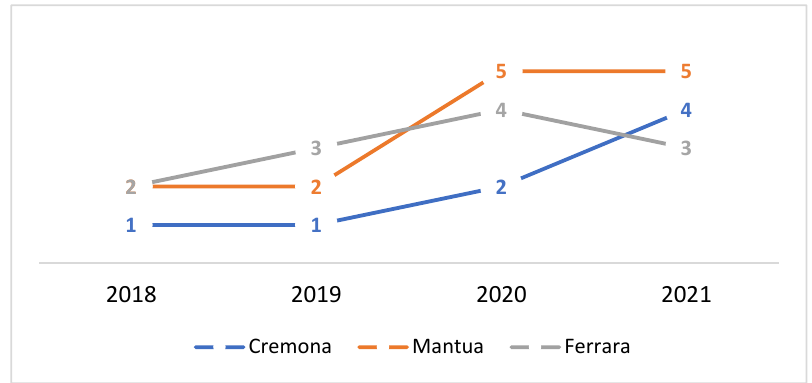
Figure 5. Number of cases per year in the first 3 provinces.